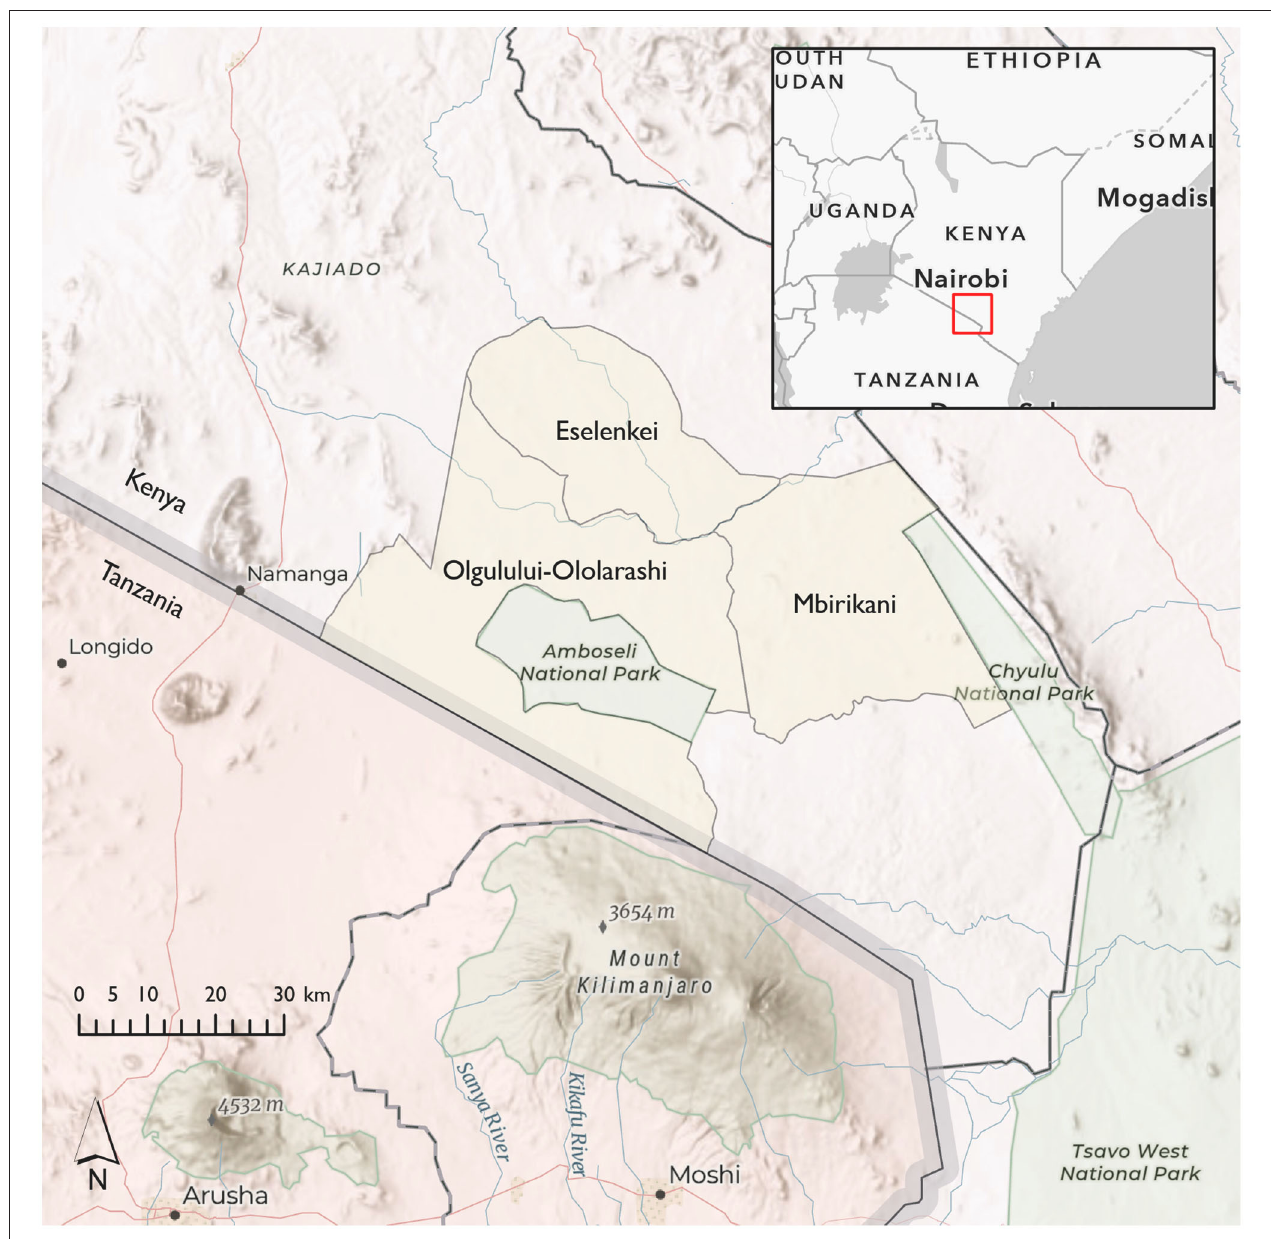
FIGURE 1 | Location of the study area, including the three Maasai group ranches.